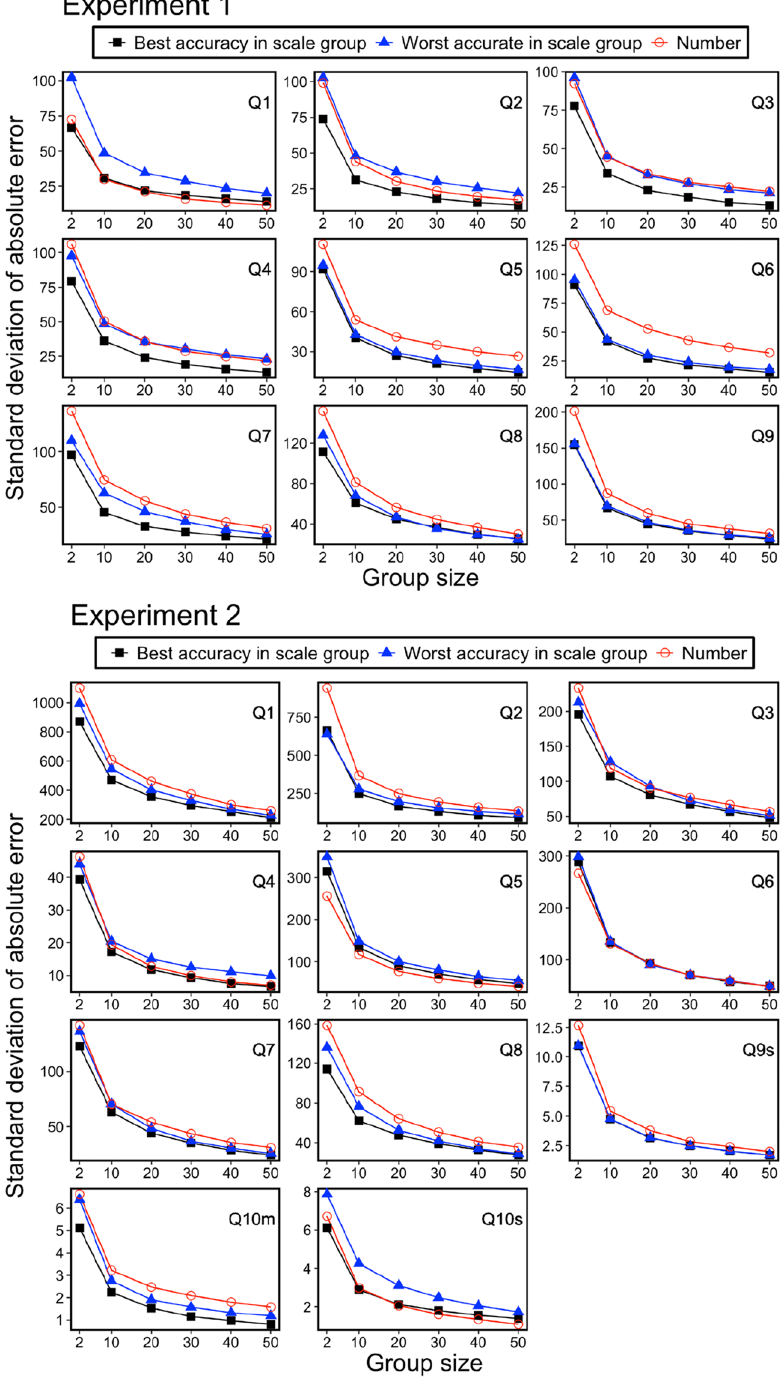
Figure 8. Standard deviation of absolute error (difference between group performances and correct answers) for 5000 computer simulations as a function of group